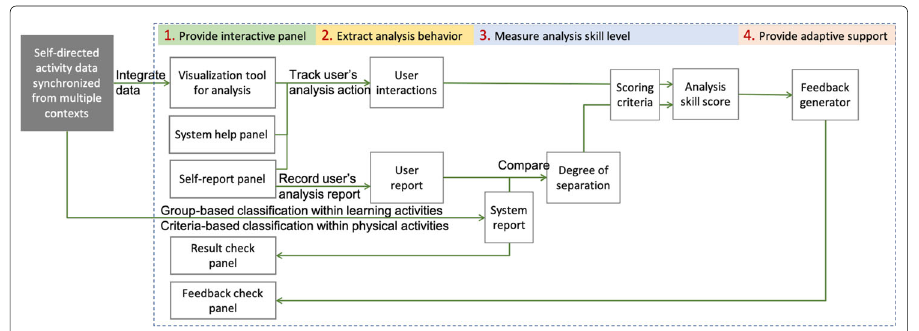
Fig. 2 Technology framework for fostering analysis